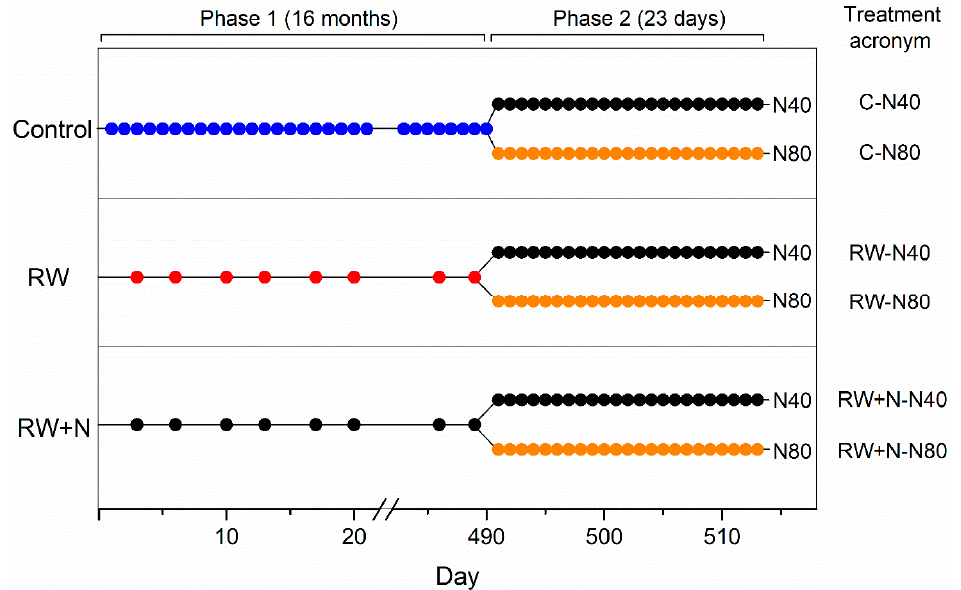
Figure 1. Graphical representation of the experimental design (see text for details). Dots indicate the frequency of daily artificial waterings. Control: samples subjected to one daily artificial watering cycle (blue dots). RW: samples watered twice per week (red dots). RW+N: samples watered with N-enriched water twice per week (black dots). During Phase 2, -N40 (black dots) and -N80 (orange dots) indicate the daily hydration of the samples with N-enriched water at two levels: 40 and 80 kg N h − 1 y − 1 .